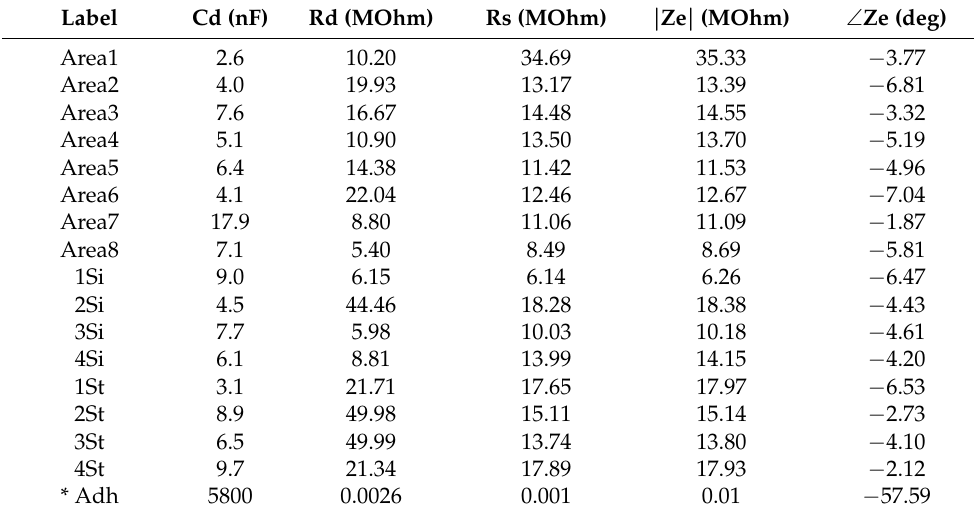
Table A1. Fitted Circuit Parameters of Woven Electrode sets the with magnitude and phase of the skin − electrode impedance at 25